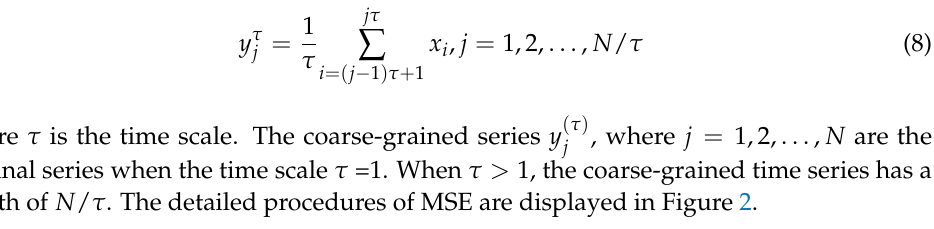
Figure 1. The illustration of conventional coarse-graining procedure: ( a ) 𝜏 is 2; ( b ) 𝜏 is 3.